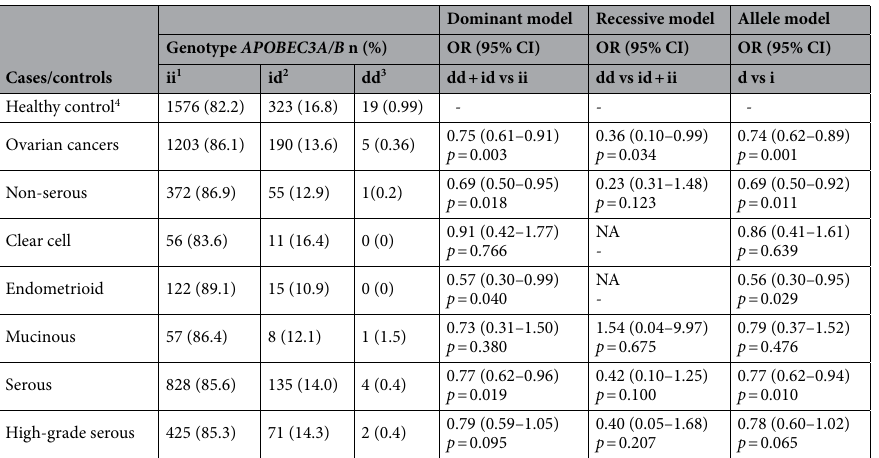
Table 1. APOBEC3A/B genotype distribution and risk estimates for ovarian cancer. 1 Genotype ins-ins. 2 Genotype ins-del. 3 Genotype del-del. 4 Previously published data